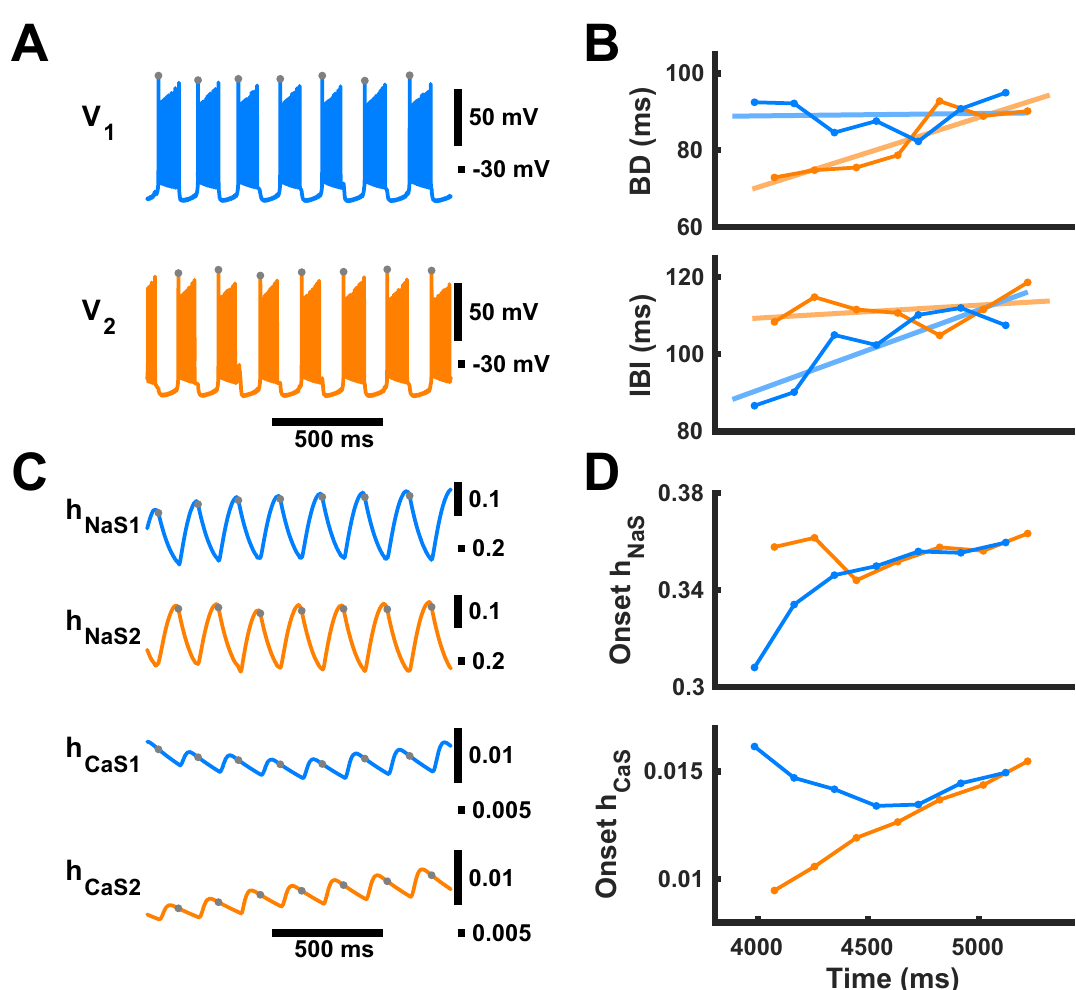
Fig 6. Progression of variables h and h throughout transient paw-shake-like response. Characteristics for neurons #1 and #2 NaS CaS are depicted in blue and orange, respectively. All panels are on the same time scale. (A) Membrane potentials during model transient paw-shake-like activity from the same simulation shown in Fig 3. Gray dots represent the time of the burst onset. (B) Changes in burst duration (BD) and interburst interval (IBI) of neurons #1 and #2 in an example of a paw-shake-like transient response, also shown in Fig 3B. (C) Progression of variables h and h during transient-paw-shake-like activity. (D) The values of variables h NaS CaS neurons #1 and #2 at the burst onsets of each neuron, which we refer to as “onset h NaS ” and “onset h CaS ”, marked by gray dots in A and C